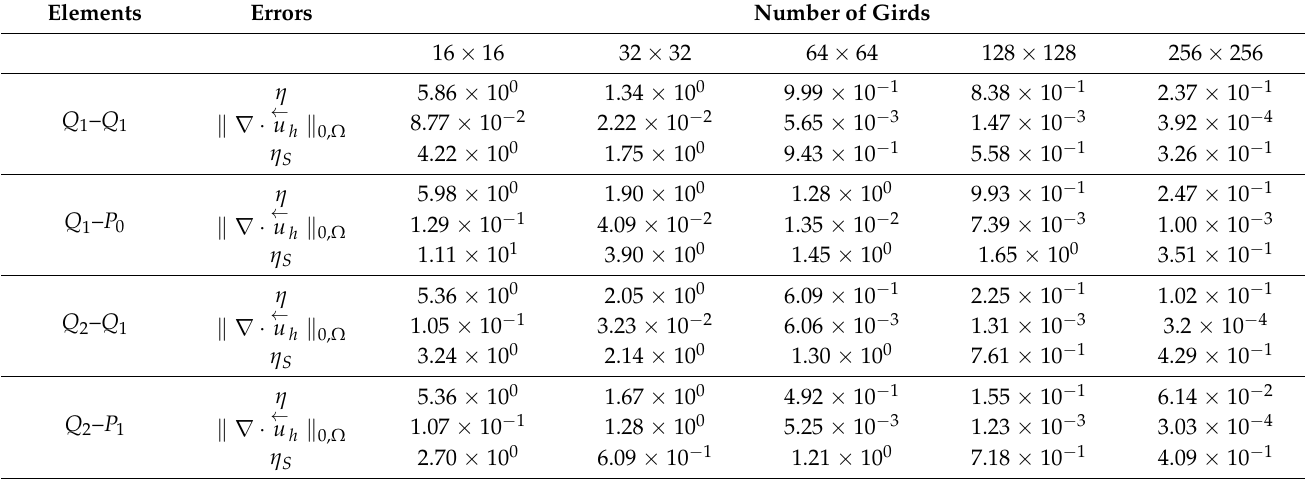
Table 1. Residual error estimator, estimated velocity divergence error, and Stokes solution residual for 16 × 16, 32 × 32, 64 × 64, 128 × 128, and 256 ×